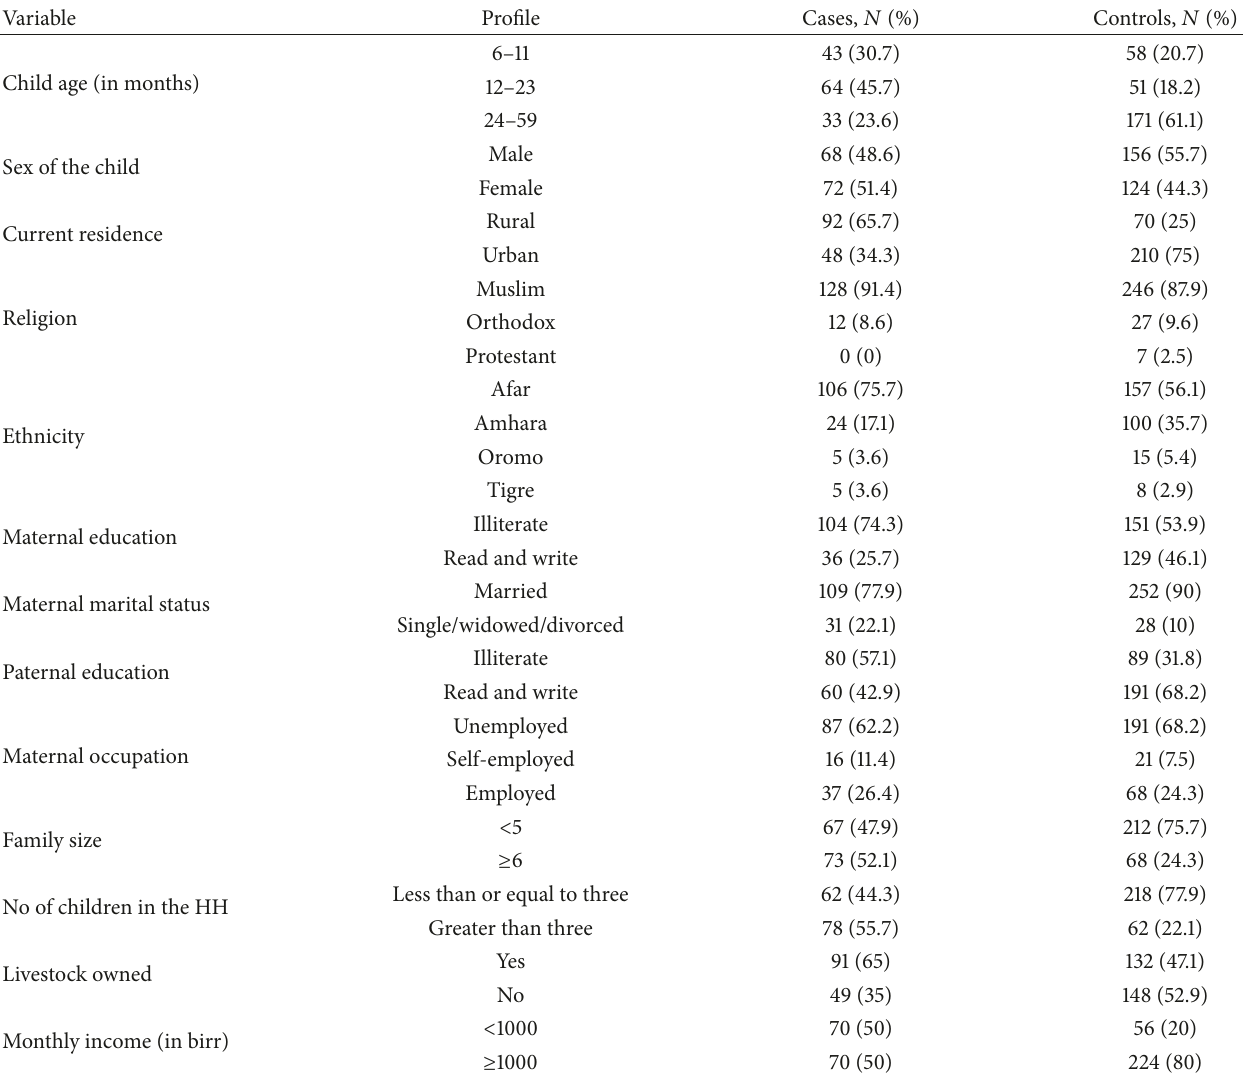
Table1:SociodemographicandsocioeconomicprofileofcasesandcontrolsinDubtiDistrict,AfarRegionalState,NortheastEthiopia,January 2014 (cases: 𝑁 = 140 and controls: 𝑁 = 280